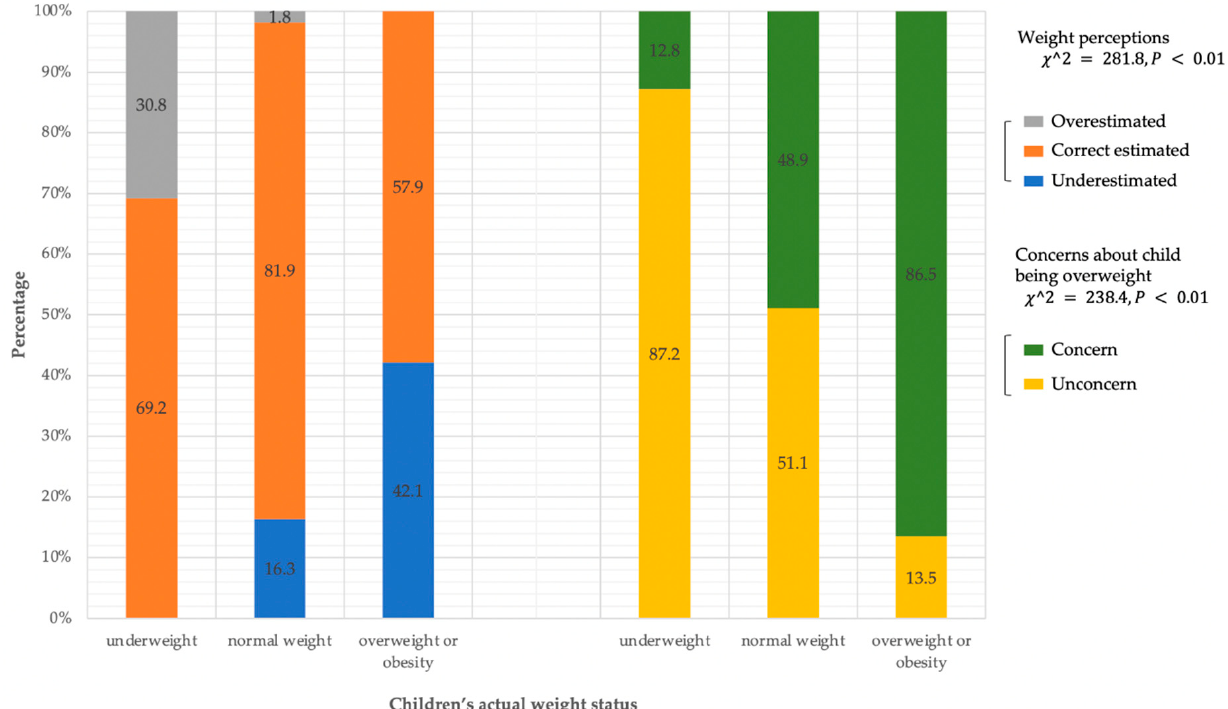
Figure 2. Parental weight perception, concerns, and actual weight status of preschoolers.